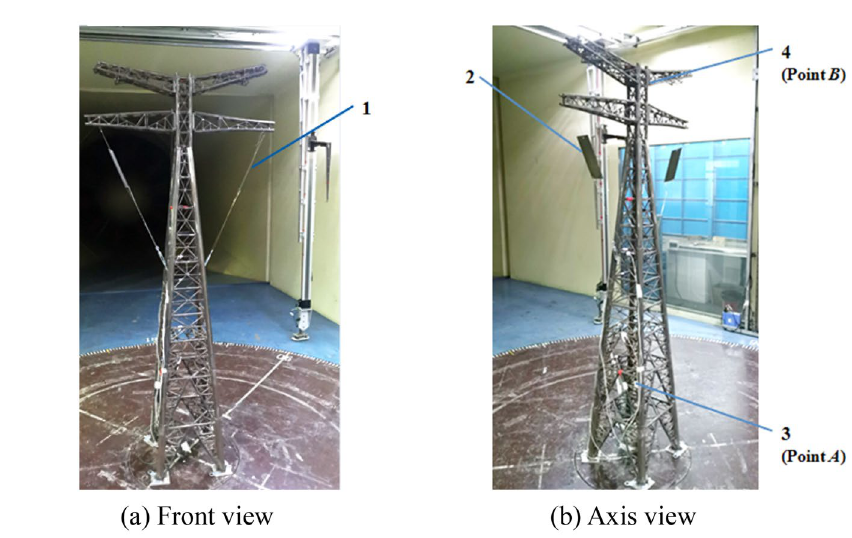
Figure 12. Wind tunnel aero-elastic test model of 500 kV ISLSTT with the new vibration reduction